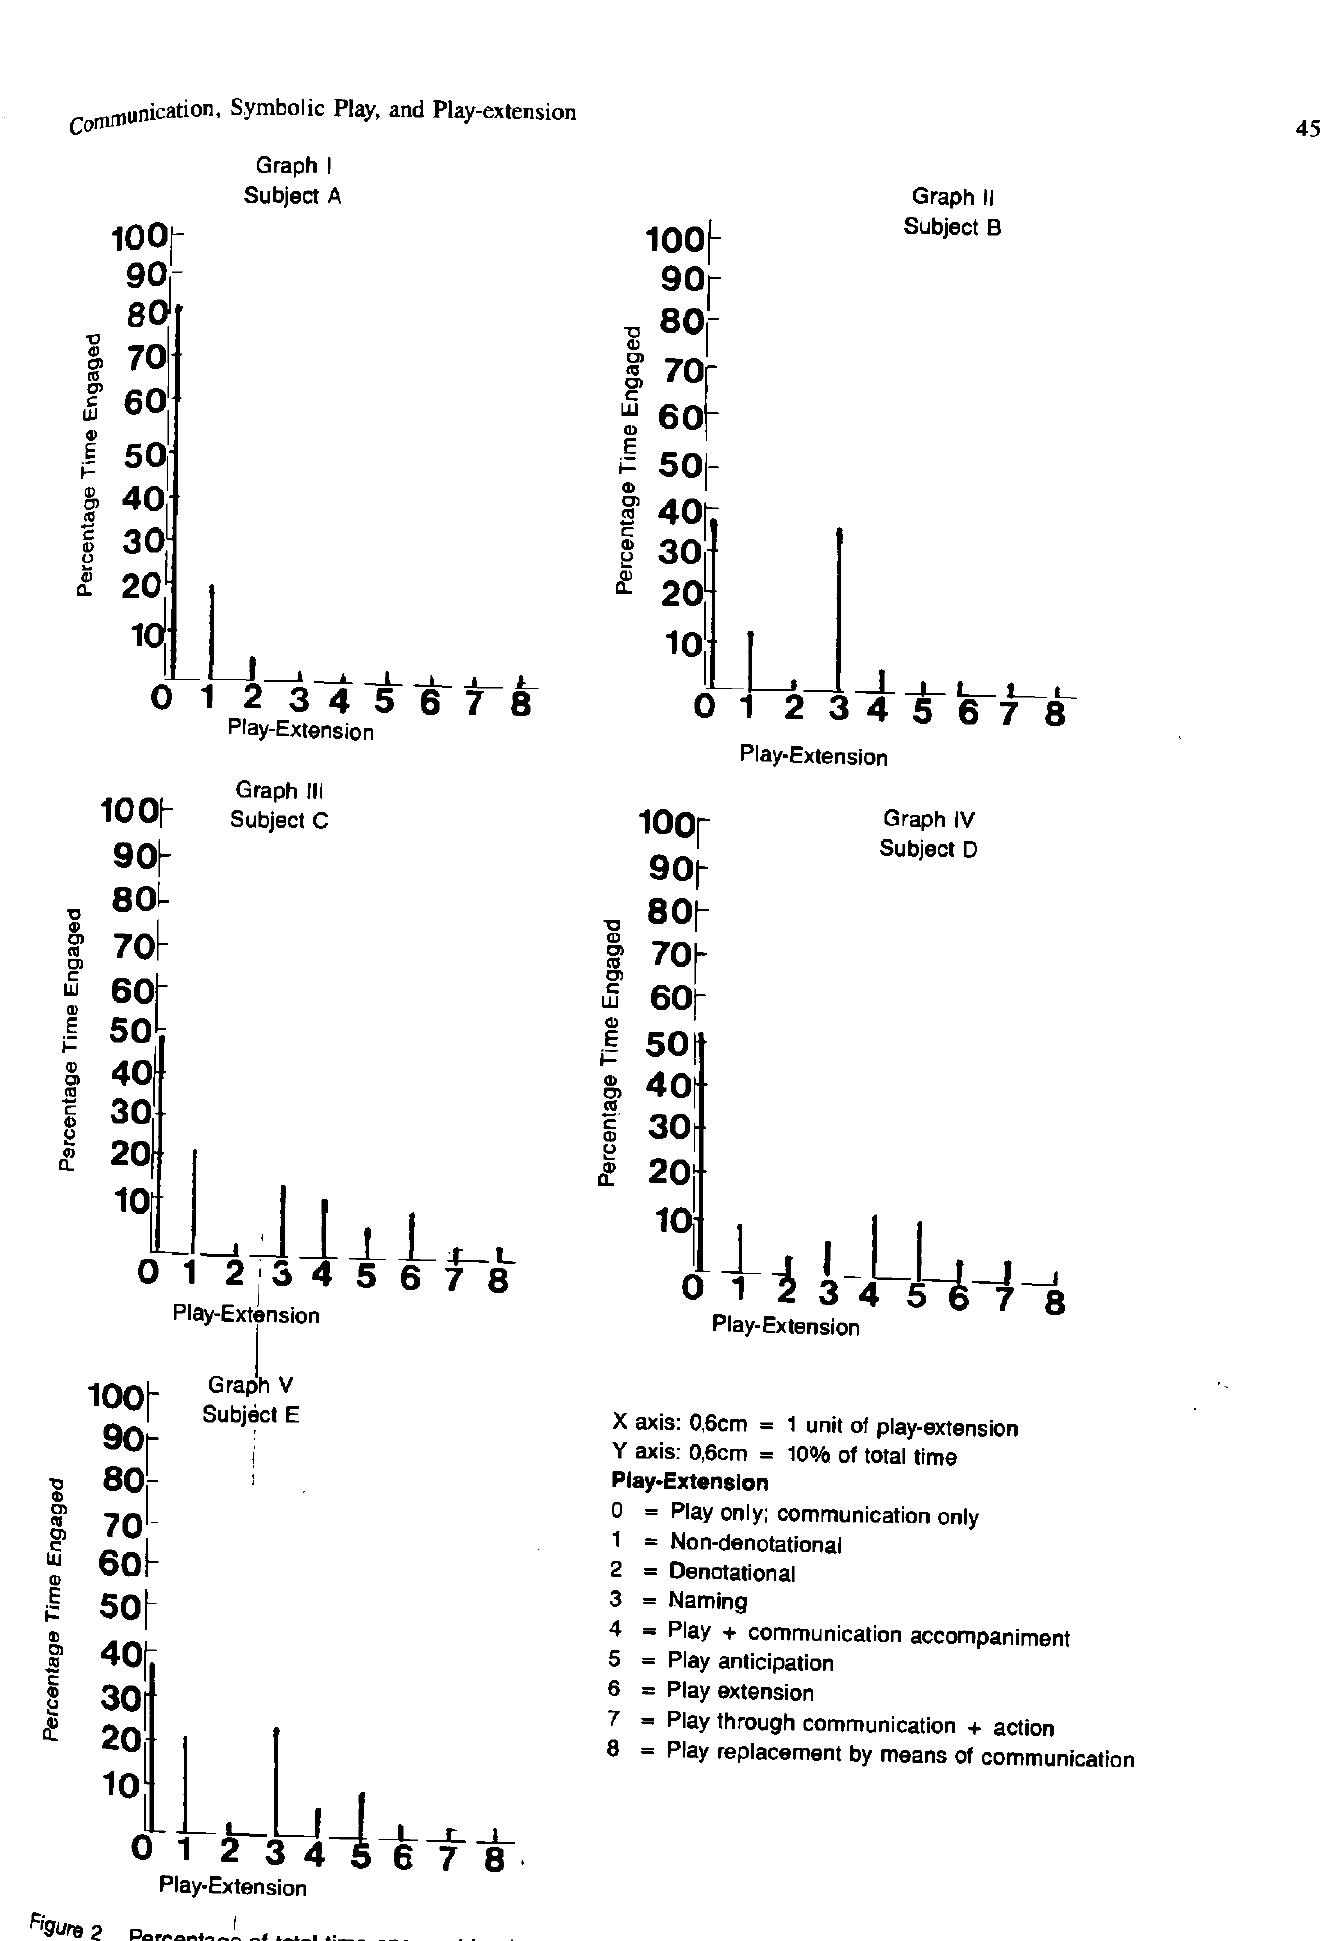
X axis: 0,6cm = 1 unit of play-extension Y axis: 0,6cm = 10o/o of total time